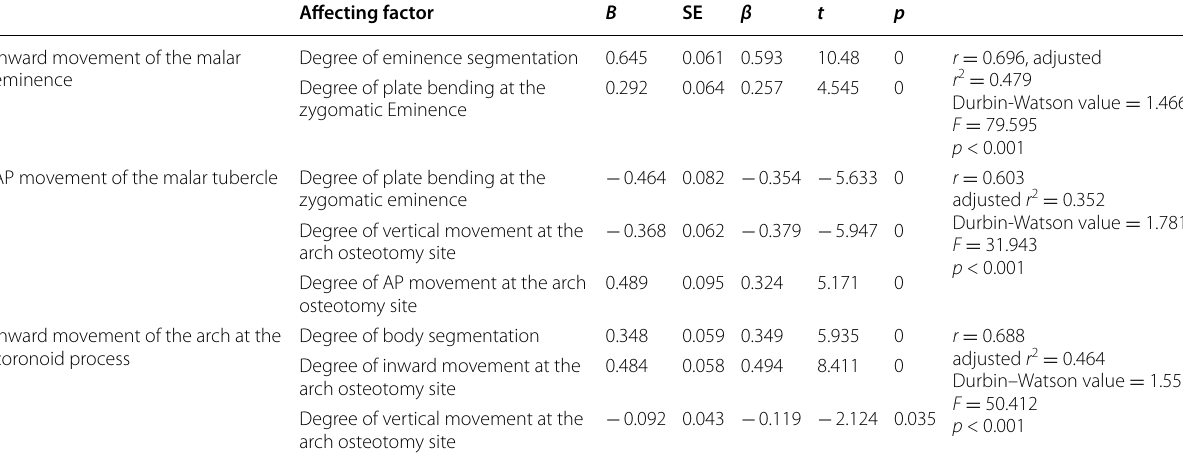
Table 3 Multiple regression analysis